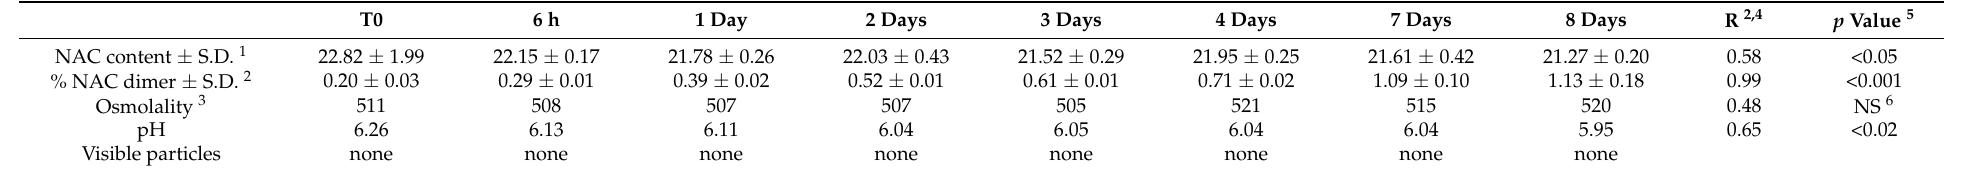
Table 5. NAC stability study, 25 ± 2 ◦ C ambient storage